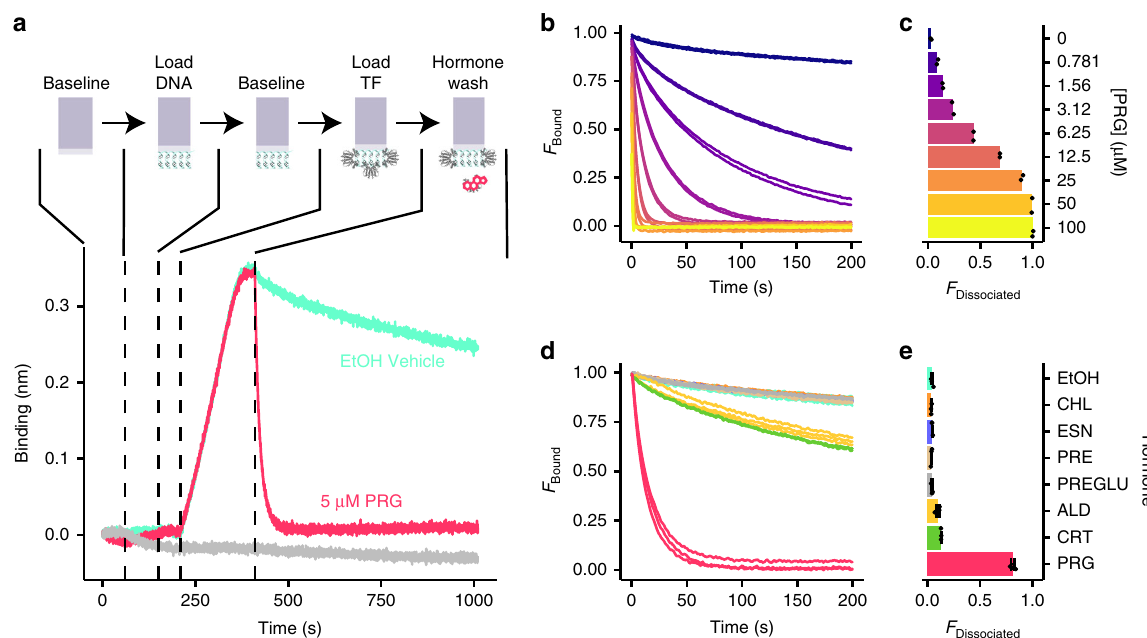
Fig. 2 SRTF con fi rmed as a progesterone responsive aTF. a Top panel: BioLayer Interferometry (BLI) experimental approach. Bottom panel, binding layer thickness on probe normalized to baseline. Probes were loaded with oligos containing the SRTF1 binding site (red line) or a scrambled sequence (gray line). Addition of progesterone resulted in rapid unbinding of SRTF1 (red line) that was not observed with vehicle control (cyan line). b Unbinding of SRTF1 is dose-responsive. Dissociation curves in duplicate were normalized such that binding at time 0 was equal to 1. c Fraction SRTF1:DNA complex from curves shown in panel b dissociated at 5 s. d Dissociation curves in triplicate of SRTF1 in the presence of 5 μ M various steroids showing strongest induction by progesterone normalized as in panel b . e Fraction SRTF1:DNA complex from curves shown in panel d dissociated at 30 s. Error bars are standard error over three experiments. Data underlying bar graphs in panels c and e are available in the Source Data fi